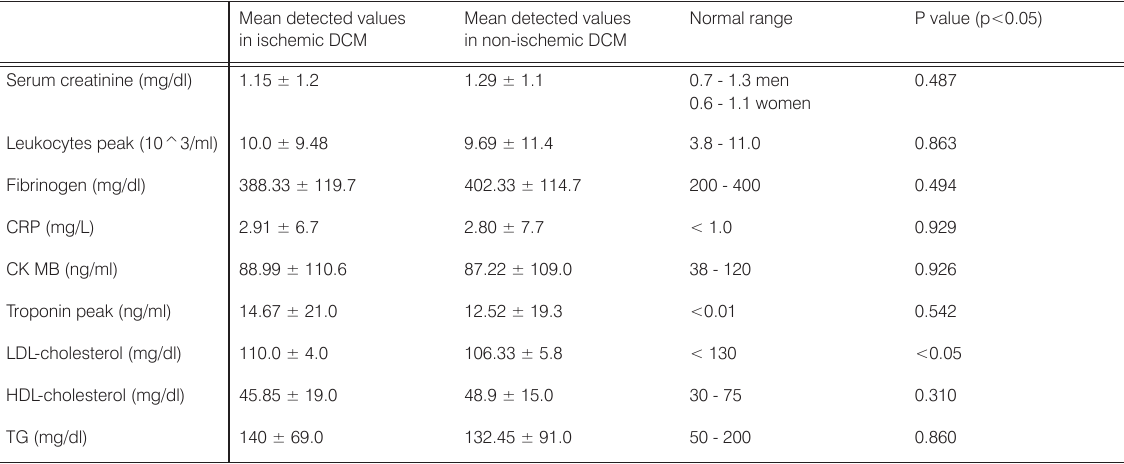
Table 3. Cytokine pattern in the enrolled population distinguishing between ischemic and non-ischemic dilated cardiomyopathy. IL: interleukin; TNF: Tumor Necrosis Factor. DCM: Dilated Cardiomyopathy. Ischemic DCM Non-Ischemic DCM Normal range P value